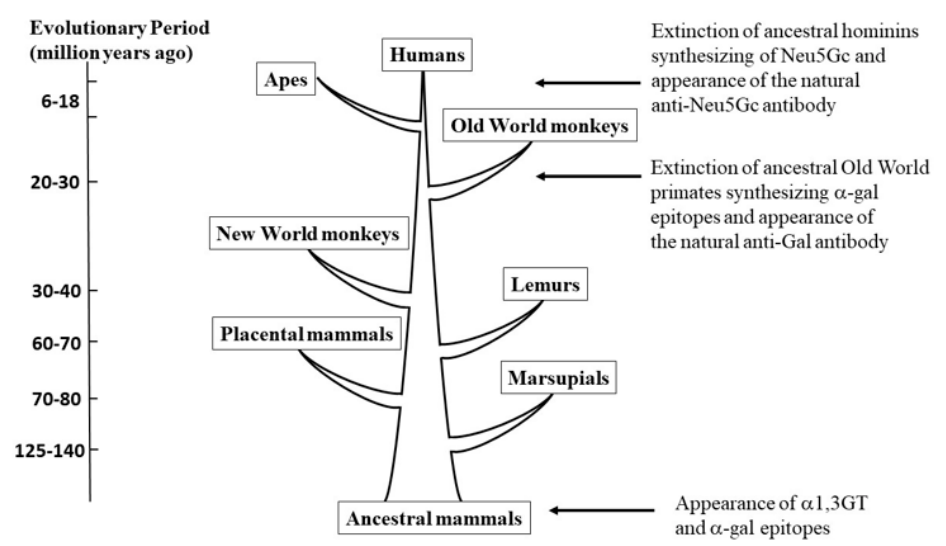
Figure 3. Suggested evolutionary periods (indicated by arrows) in which the α -gal epitope and Neu5Gc carbohydrate antigens were eliminated and the anti-Gal and anti-N-glycolyl neuraminic acid (anti-Neu5Gc) antibodies appeared as a result of viral epidemics. The presence of α -gal epitopes only in mammals and in no other vertebrates implies that synthesis of α -gal epitopes initiated in mammals at an early evolutionary period before marsupials and placental mammals diverged from a common ancestor. The absence of α -gal epitopes only in humans, apes and Old World monkeys implies that the elimination of primates synthesizing this epitope and the corresponding production of the natural anti-Gal antibody occurred in ancestral Old World primates ( catarrhini ) after they diverged from New World monkeys ( platirrhini ). N-5-glycolyl-neuraminic acid (Neu5Gc) is synthesized in most mammals (including apes and Old World monkeys) and other vertebrates, but it is absent in humans. In contrast, humans produce the natural anti-Neu5Gc antibody. This strongly suggests that elimination of Neu5Gc occurred after hominins and ancestors of chimpanzee diverged from a common ancestor. Modified from “The natural anti-Gal antibody as foe turned friend in medicine” by U. Galili, 2018, Elsevier / Academic Press, p. 25.